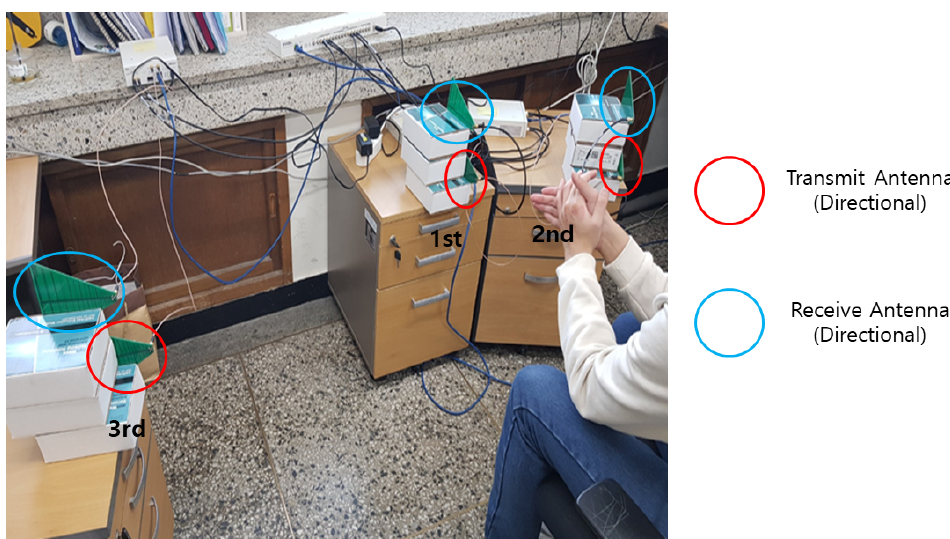
Figure 6. Experiment setting for three distributed radars.